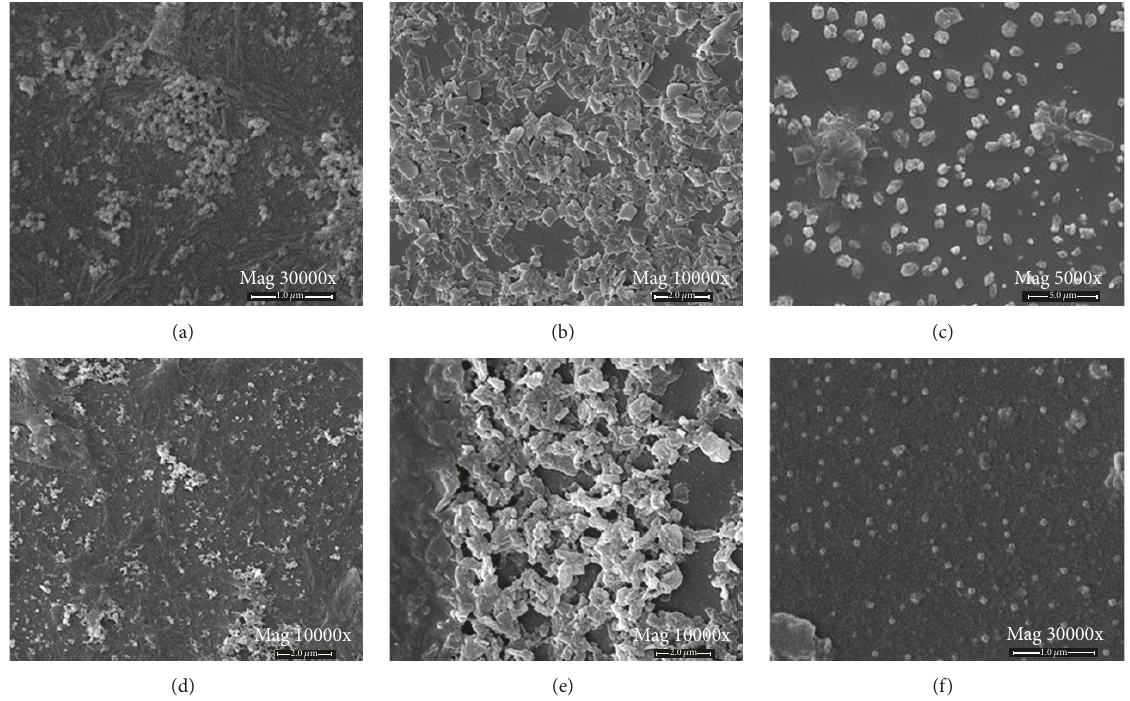
Figure 4: SEM images of HCPTNPs using poloxamer 188 as surfactants under different HP and amount conditions: (a) 0.5 mg, 600 bar; (b) 0.5 mg, 800 bar; (c) 0.5 mg, 1000bar; (d) 2.5 mg, 600 bar; (e) 2.5 mg, 800 bar; (f) 2.5 mg, 1000 bar.